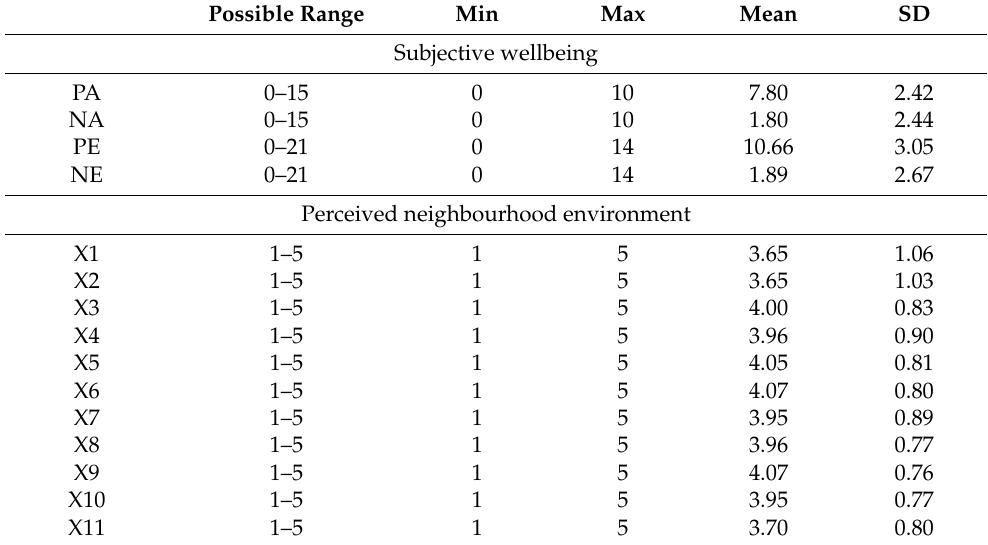
Table 2. Descriptive statistics of subjective wellbeing and perceived neighbourhood environment.